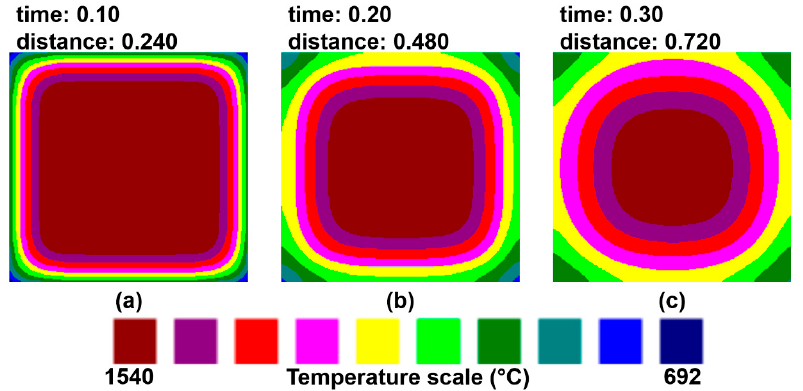
Figure 9. ( a – c ) Temperature profiles inside the mold (assumed symmetrical removal). The positions of these profiles are a function of the distance, taken as a reference at the meniscus level; time (min) and distance (m).